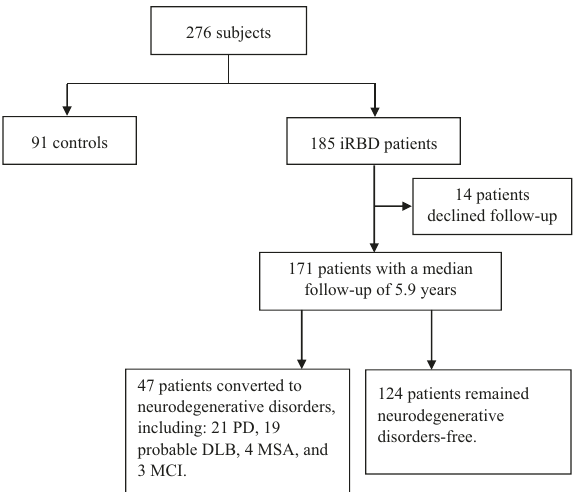
Fig. 1 Flowchart of study. DLB, Dementia with Lewy bodies; iRBD, idiopathic rapid eye movement sleep behavior disorder; MCI, mild cognitive impairment; MSA, multiple system atrophy; PD, Parkinson ’ s disease.